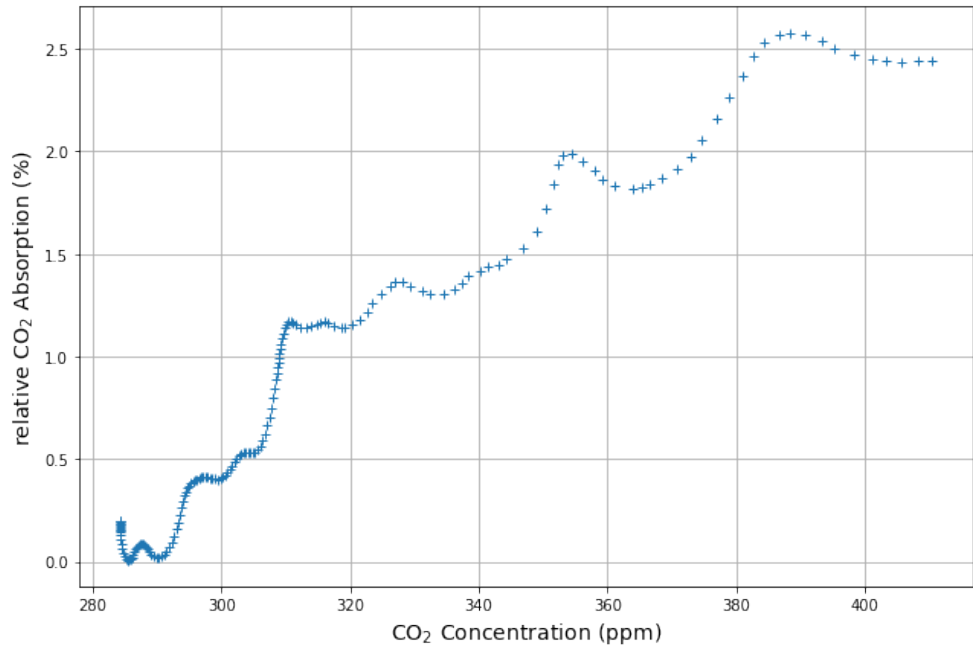
Figure 2. Effective absorption vs CO 2